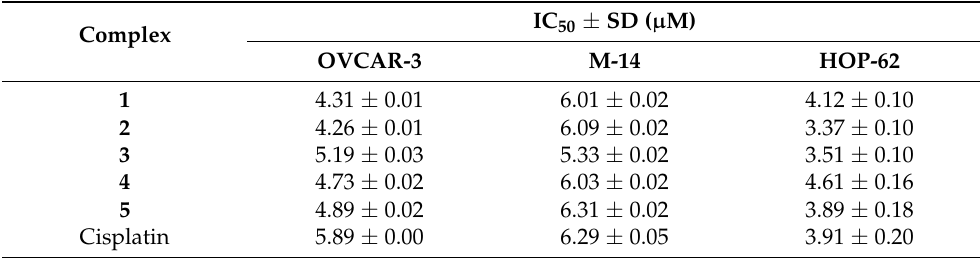
Table 3. Anticancer activities of selected compounds in DMSO